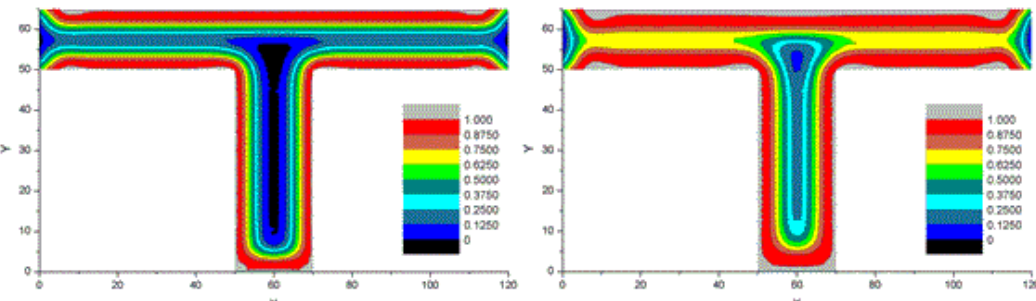
Figure 14 – Isoprobability maps for 25 years and 50 years. Extreme environment